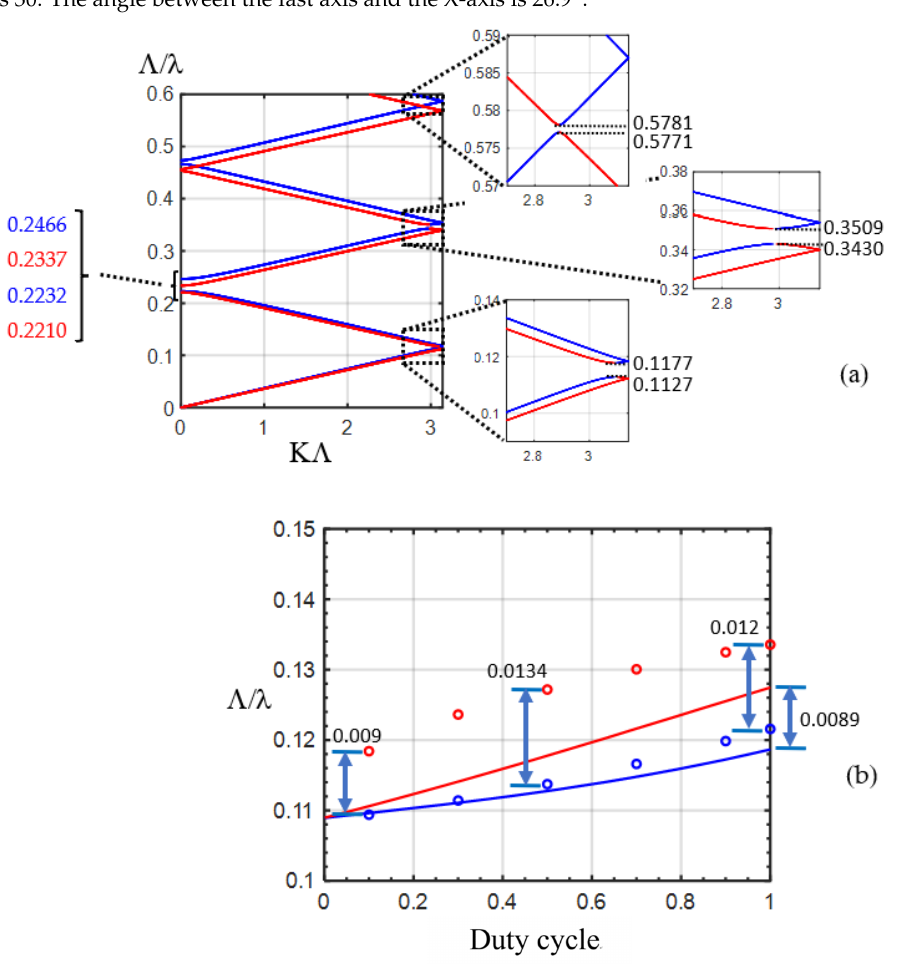
Figure 6. ( a ) Band structure of the stack of birefringent waveplates with isotropic background for a duty cycle of 0.5. ( b ) The band edges of the first bandgap for different duty cycles. The solid lines are obtained from the band structure. The circles are acquired from the frequencies at half maximum of the peak at around Λ / λ = 0.12, as shown in Figure 2b. 4. Discussion The band edges of the first bandgap are shown in Figure 6b for different duty circles. The red and blue solid curves present the upper and lower band edges of the first band, respectively, for different duty cycles. We can observe that the bandwidth increases with increasing duty cycle. For the duty cycle of 100%, the bandwidth is 0.0089. The red and blue circles present the frequencies at the half maximum for the peak at around Λ / λ =